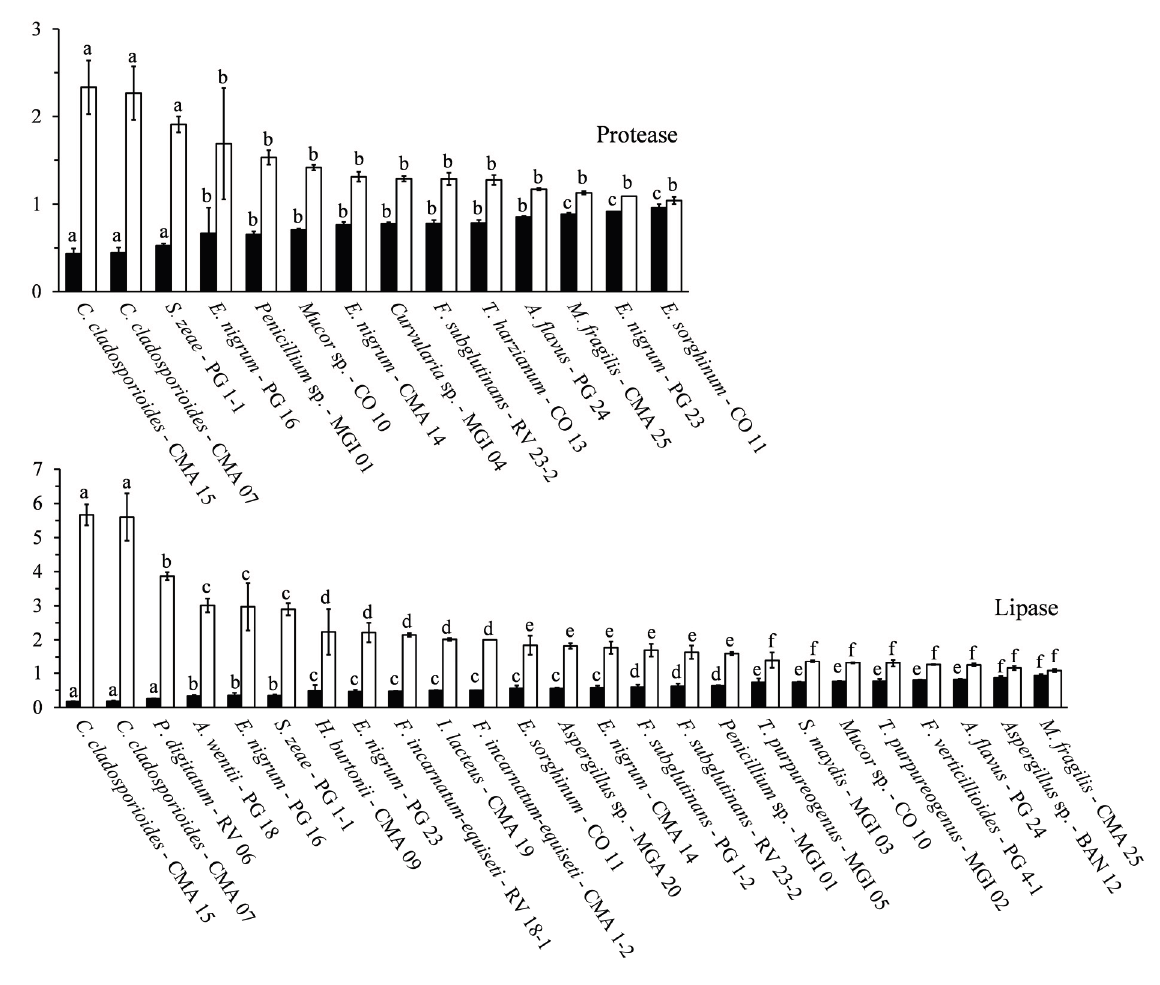
Figure 3. Enzyme activity analysis. The data are the average and standard deviation obtained in three repetitions. Enzyme activity was expressed as the Enzymatic Index ( □ ) or as the 1-(C/H) index ( ■ ). Averages followed by the same letter are not significantly different according to the Scott-Knott test ( α = 0.01). Averages are ordered following the Enzymatic